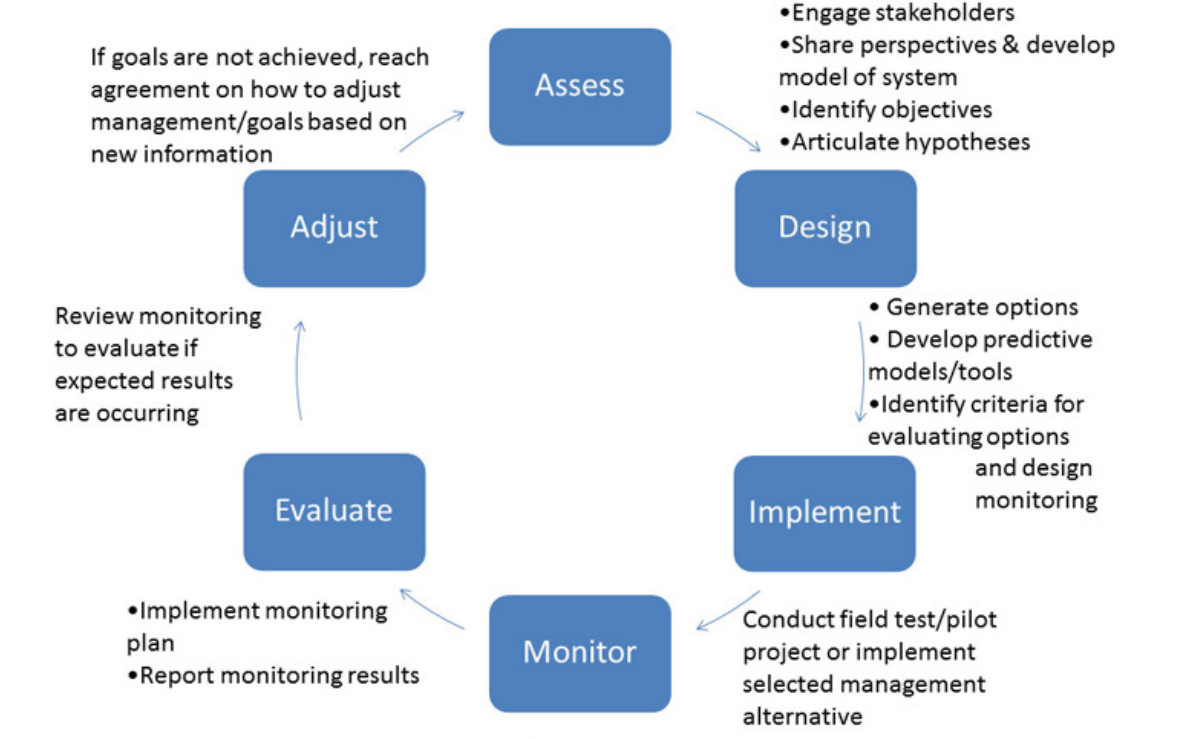
Fig. 1 . Annotated adaptive managment cycle, adapted from Nyberg